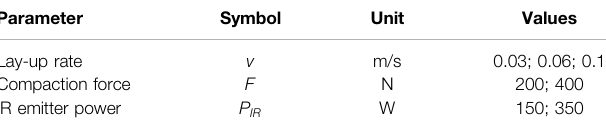
TABLE 2 | AFP process parameters for lay-up trials and peel tests. Parameter